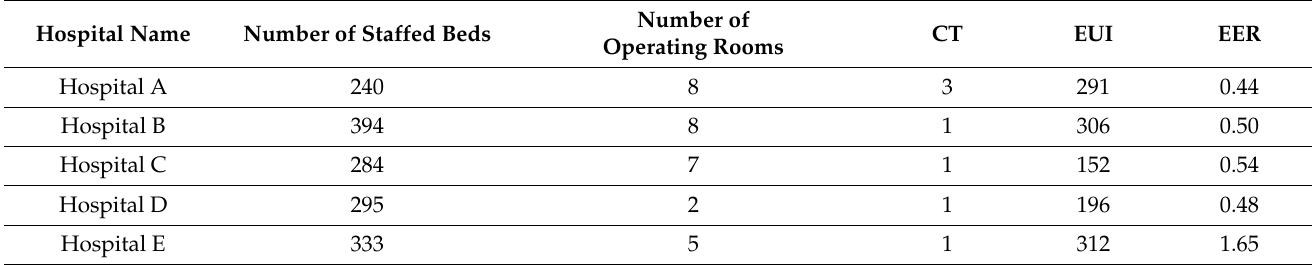
Table 12. Business activities and EUI and EER information of field survey hospital.